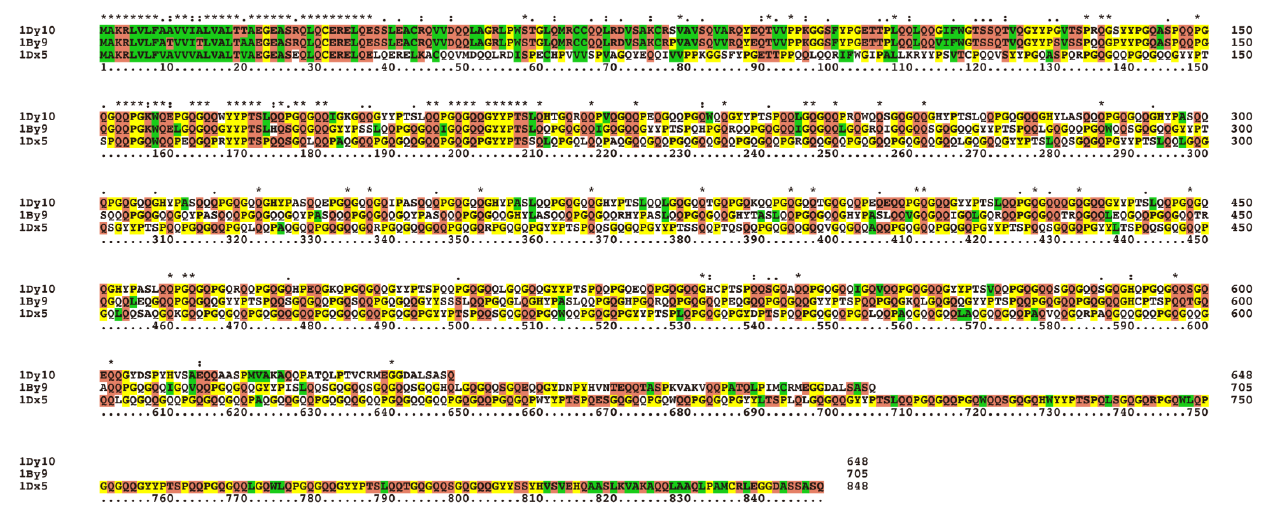
Figure 2. “ *” indicates identical amino acid residues, “ ꞉ ” indicates similar amino acid residues, and “ ꞏ ” indicates less similar amino acid residues. Yellow indicates amino acid residues G, P, C, H, Y; red indicates amino acid residues T, S, N, Q, E, D, K, R; green indicates amino acid residues W, L,V,I,F,A,M,C.